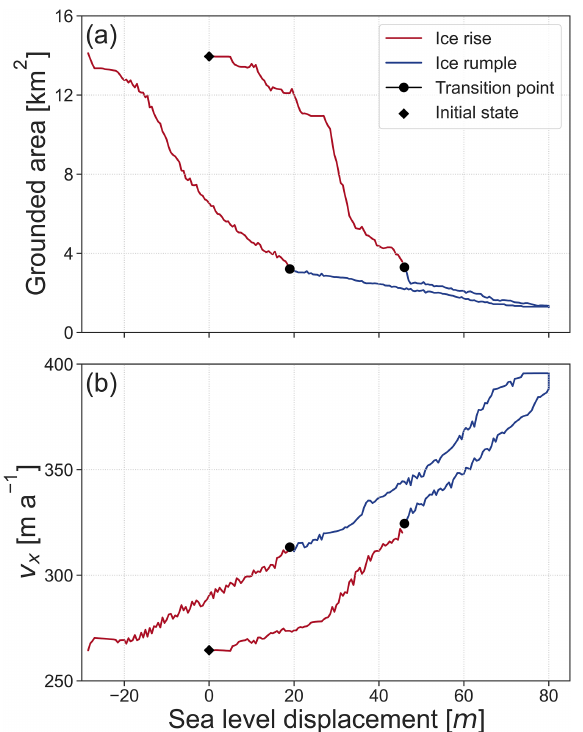
Figure A1. The response of the grounded area and ice shelf ve- locity to sea level perturbation in the intermediate-friction scenario. In (a) , the grounded area is plotted against sea level displacement, and in (b) , the average velocity in the x direction in a cross-section upstream of the ice rise (at 20km from the influx boundary) is plot- ted against sea level displacement. Red indicates that the system ex- hibits a characteristic flow regime of an ice rise, and blue indicates that of an ice rumple.